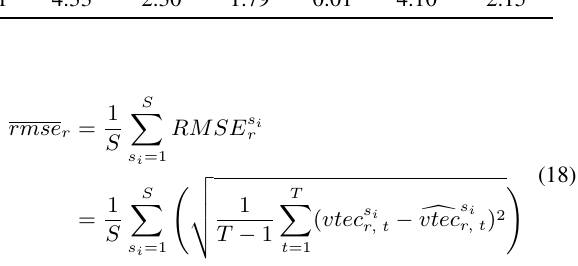
Site leij Metric mae